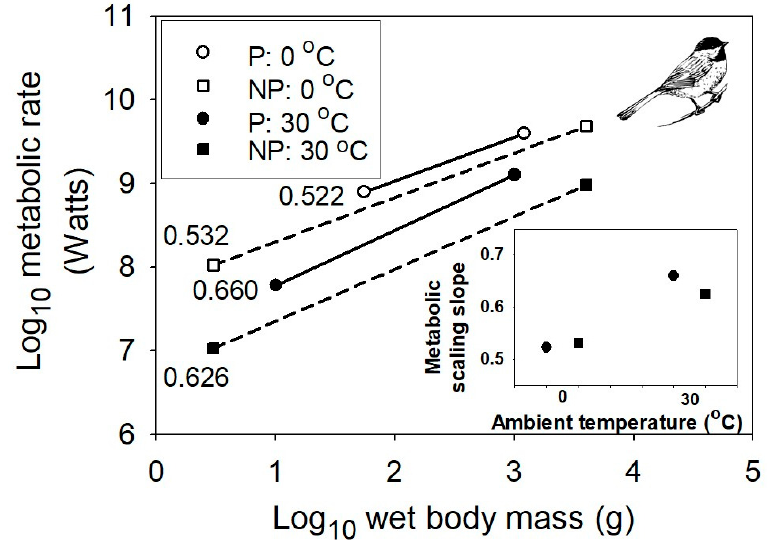
Figure 3. Interspecific scaling of existence metabolism in relation to body mass for multiple species of passerine and non-passerine birds at two different air temperatures, 0 and 30 °C (data from [56]). The sample sizes ( n ) are 71 for passerine birds, and 40 for non-passerine birds. The inset graph shows the positive relationships between the metabolic scaling slopes and temperature for both passerine and non-passerine birds. The bird picture is from [57].